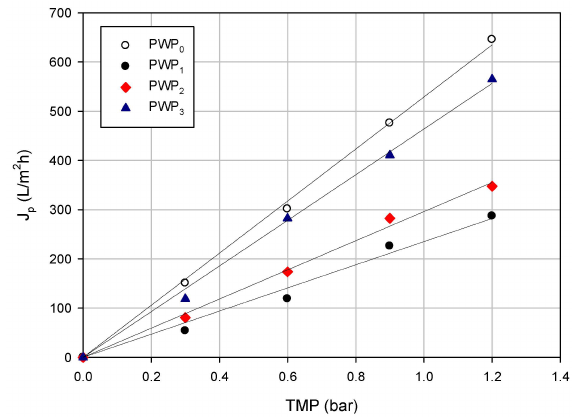
Figure 4. Pure water permeability of PVDF FH membranes before and after washing cycles (PWP 0 , initial pure water permeability; PWP 1 , pure water permeability after press liquor filtration; PWP 2 , pure water permeability after cleaning with water; PWP 3 , pure water permeability after chemical